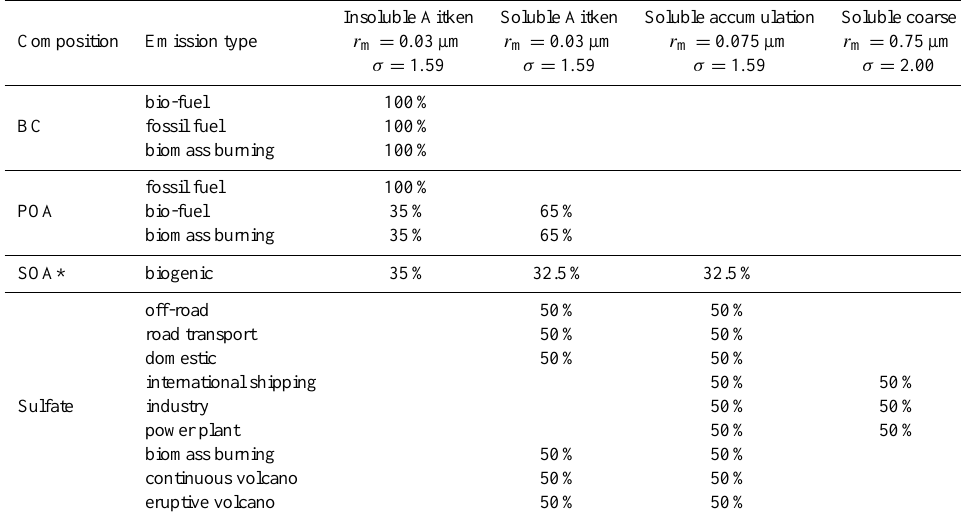
Table 2. Partitioning (mass fraction) of the primary aerosol emissions of sulfate, black carbon (BC) and organic aerosols (POA and SOA) among different modes in ECHAM-HAM. r m and σ are the median radius and standard deviation of the emitted particles. Note that SOA emissions are considered as primary emissions in HAM1, while in HAM2 the formation of SOA via chemical production is explicitly